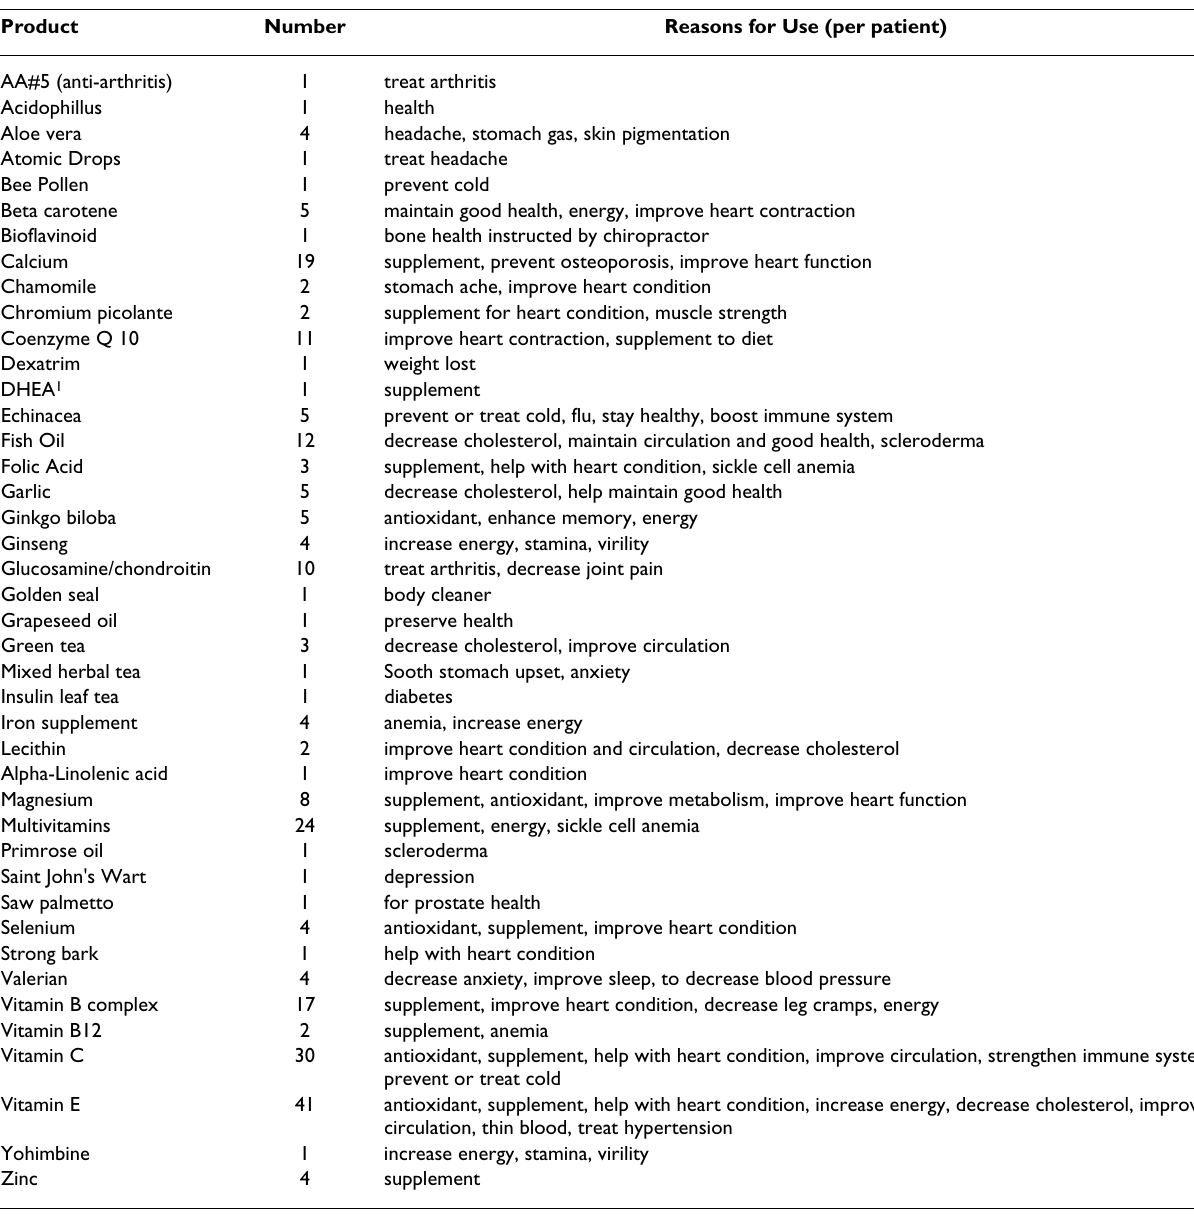
Table 3: All Biological Based Therapies Utilized by Cardiovascular Patients (at any time) Product Number Reasons for Use (per